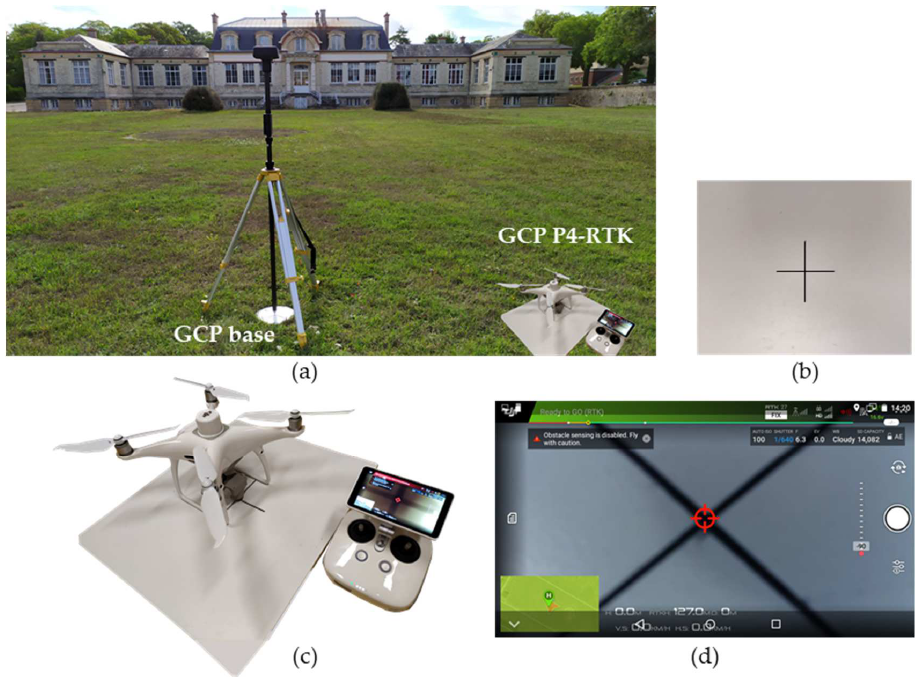
Figure 6. Measurement of the P4-RTK DGNSS receiver accuracy in static mode on the ground. ( a ) Two GCP, one for the D-RTK2 station and one for the P4-RTK; ( b ) P4-RTK GCP was a white wooden board, with a black cross in its center; ( c ) P4-RTK camera centered on its GCP; ( d ) remote controller screen, the black cross appeared in the GS RTK application (camera) and Custom Aim application created a red crosshair overlay in the center of the display, on top of the GS RTK application.